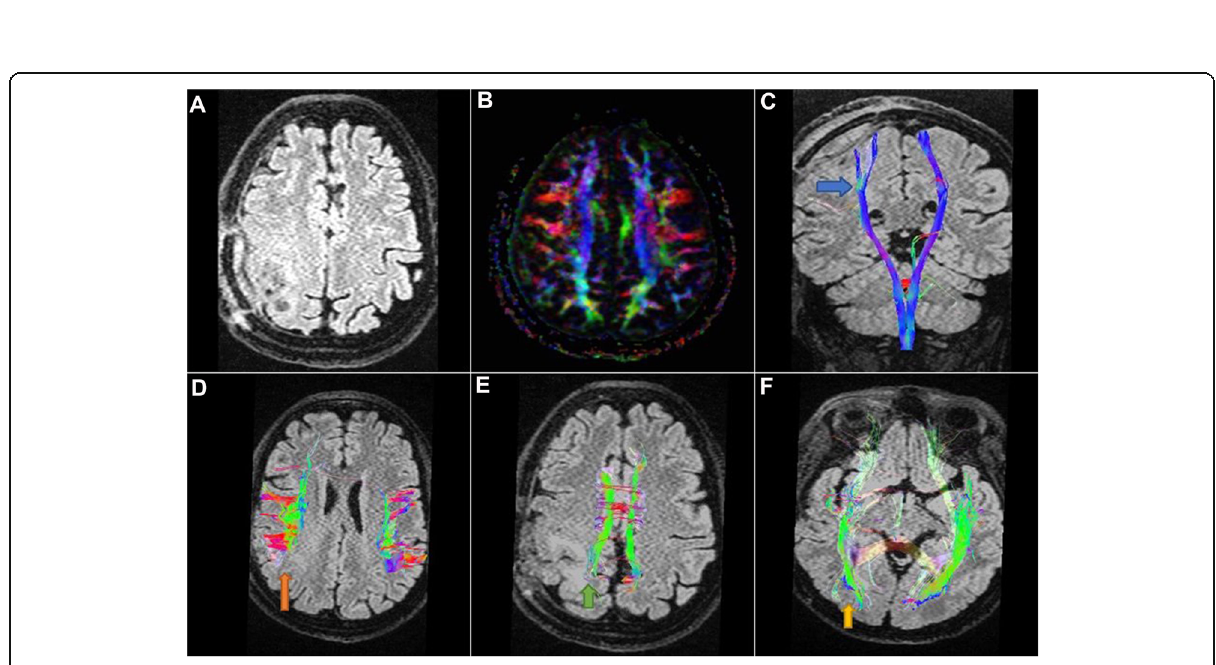
Fig. 2 Case number 1. Postoperative radiological examination of Fig. 1 patient. a , b Axial FLAIR WI and DTI color-coded map revealing right parieto-occipital craniotomy flap with right parietal postoperative changes, no residual masses. c Sagittal FLAIR WI with 3D reconstruction of the corticospinal tracts revealing normalization of position and anisotropy of the splayed tracts (blue arrow). d Axial FLAIR WI with 3D reconstruction of superior longitudinal fasciculus (orange arrow). e Axial FLAIR WI with 3D reconstruction of the cingulum (green arrow) revealing normalization of anisotropy. f Axial FLAIR WI of inferior longitudinal fasciculus (yellow arrow) revealing normalization of position and anisotropy of their